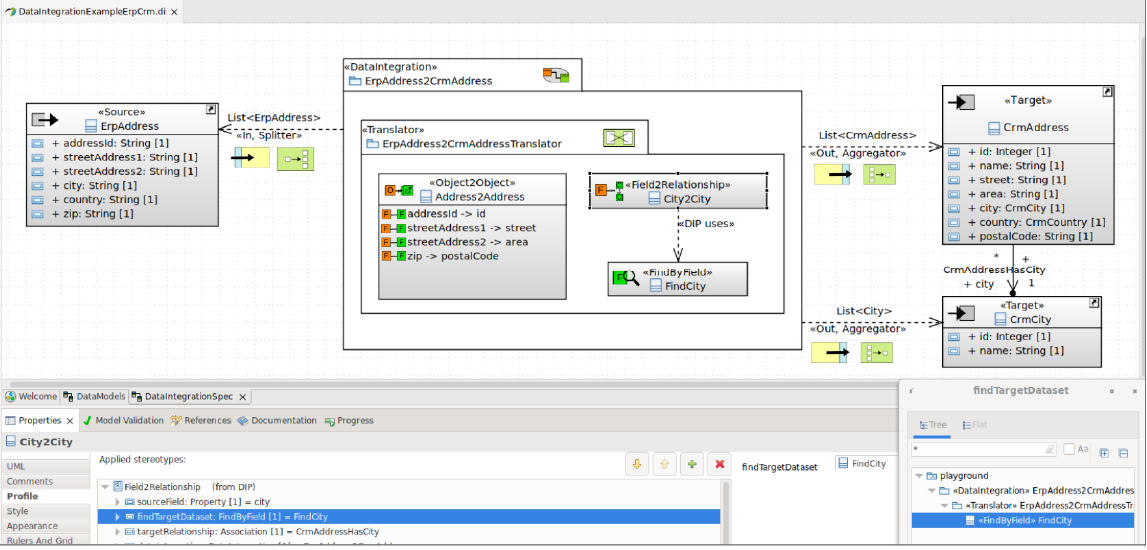
Figure 10. Visual model-based specification of the data integration example for customer addresses.